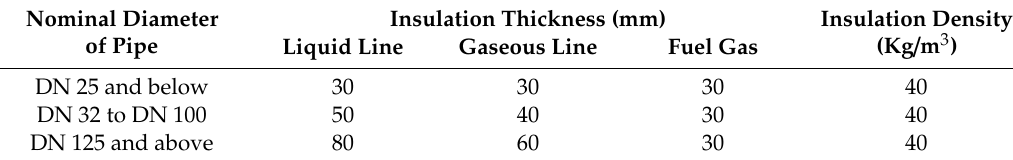
Table 2. Material property and thickness of pipe insulation.